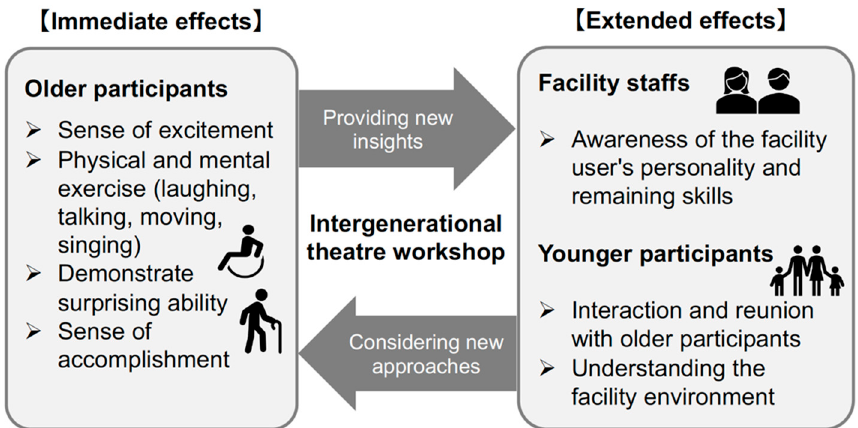
Figure 2. The impact of the intergenerational theater workshop. Themes overview of the impact of the intergenerational theater workshop emerged from the qualitative